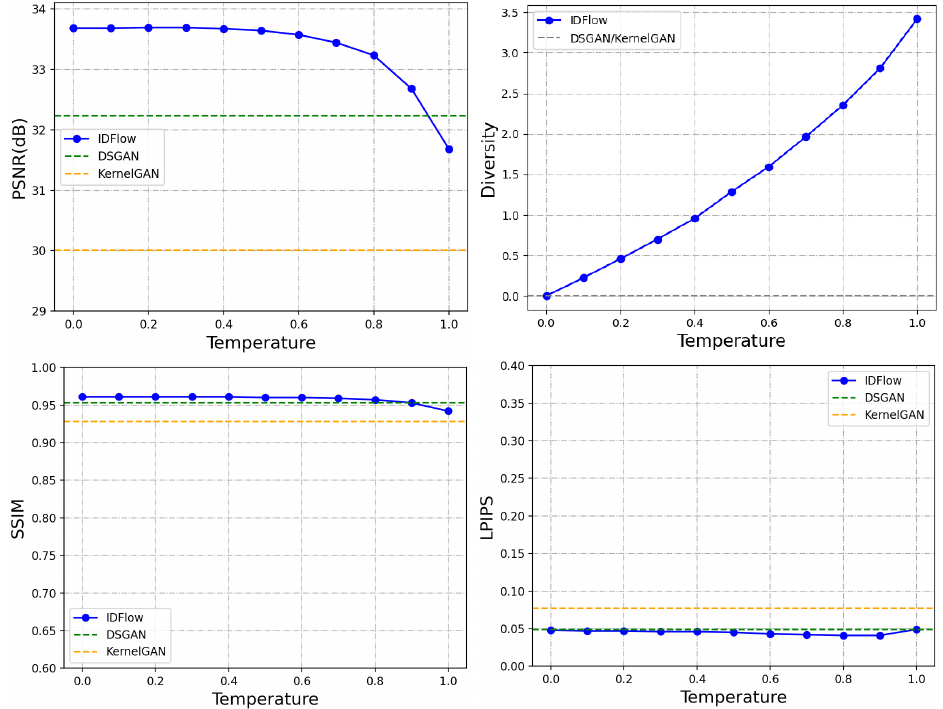
Figure 3. The effect of different τ on degradation performance of IDFlow. PSNR, diversity, SSIM, and LPIPS results are reported. The results of DSGAN and KernelGAN are introduced as a